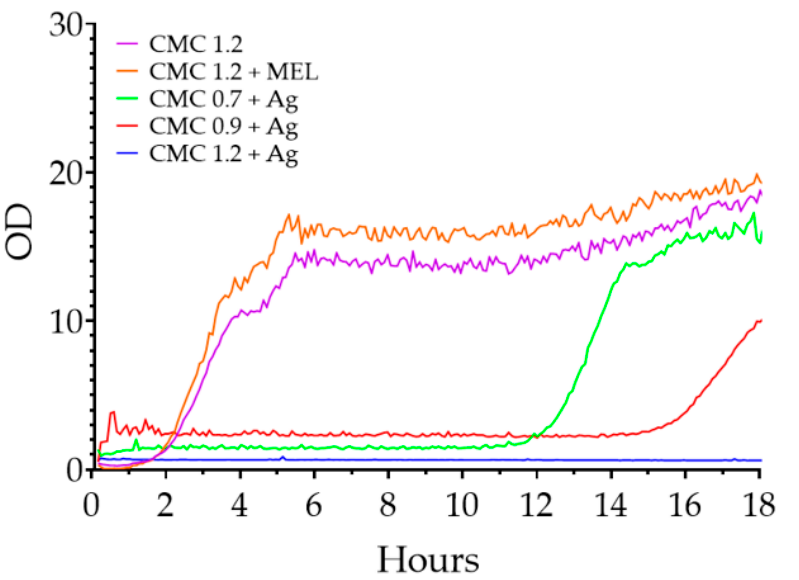
Figure 11. Changes in the optical density of liquid P. aeruginosa cultures in the presence of the films tested.